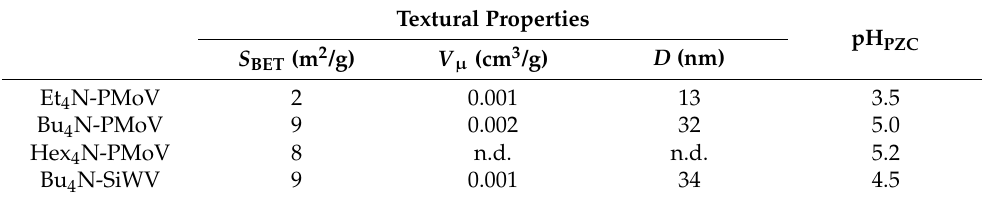
Table 1. Textural and acidic properties of solid HPA catalysts. Textural